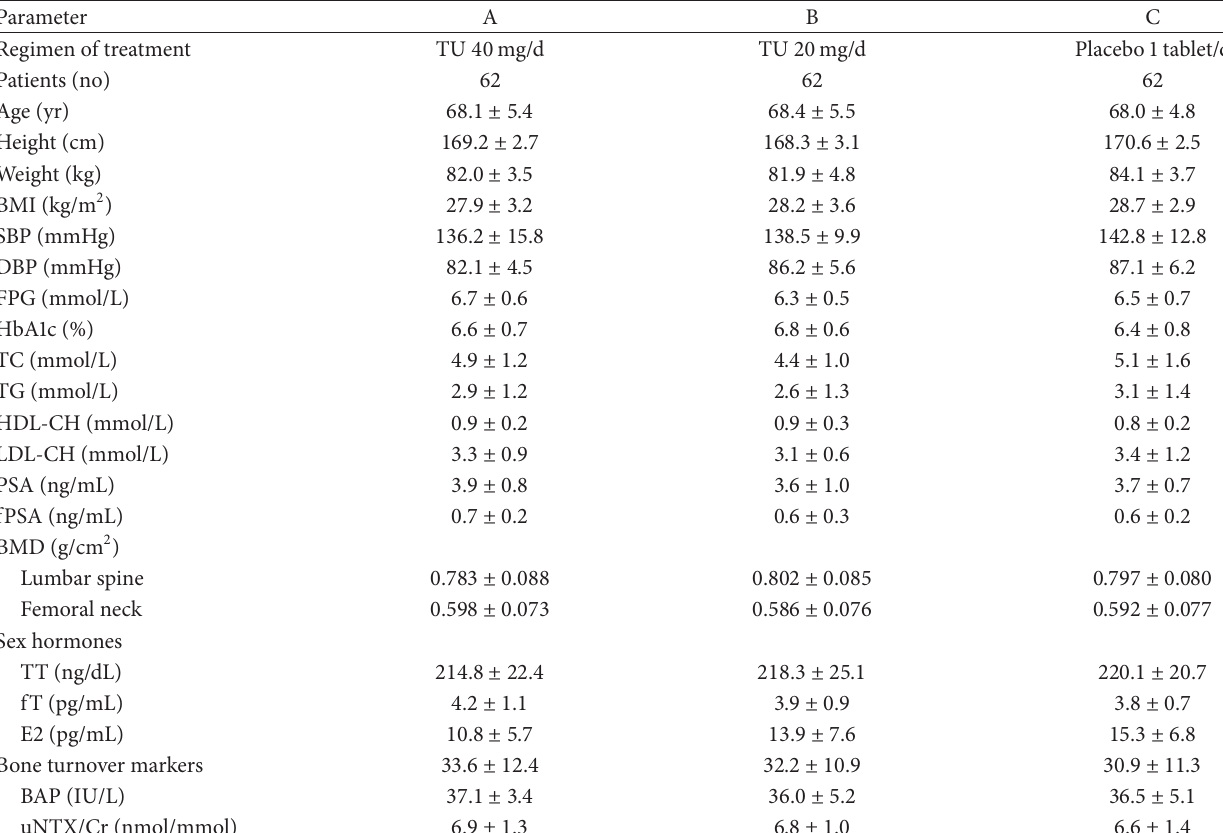
Table 1: Characteristics of the patients at the entry (means ± SD).